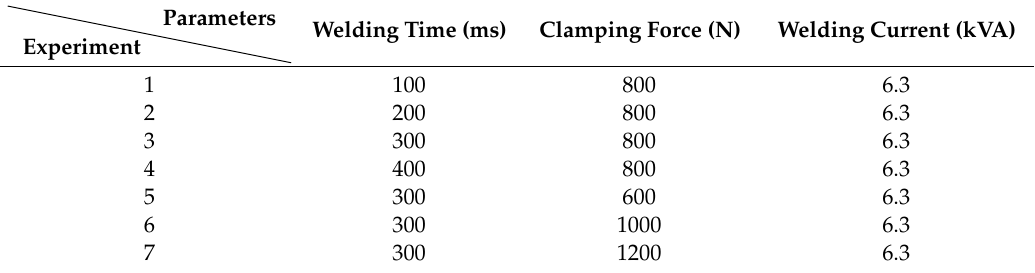
Table 1. The parameters and settings